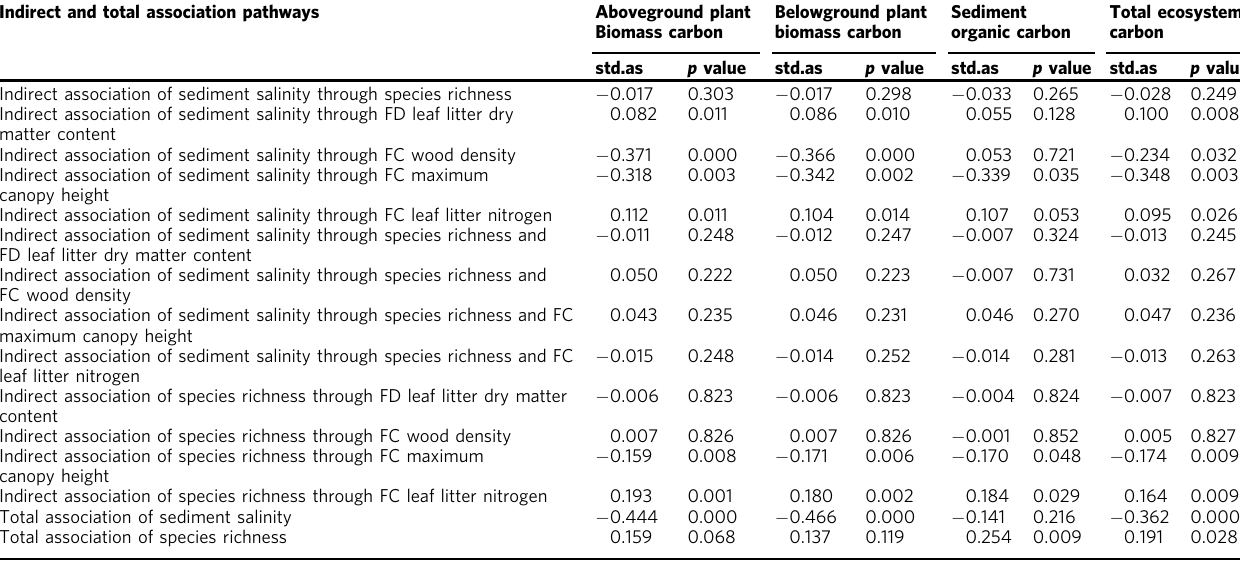
The indirect and total associations of sediment salinity and species richness were based on structural equation models. The signi fi cant standardized associations (std.as) have p value<0.05. FD Functional diversity, FC Functional